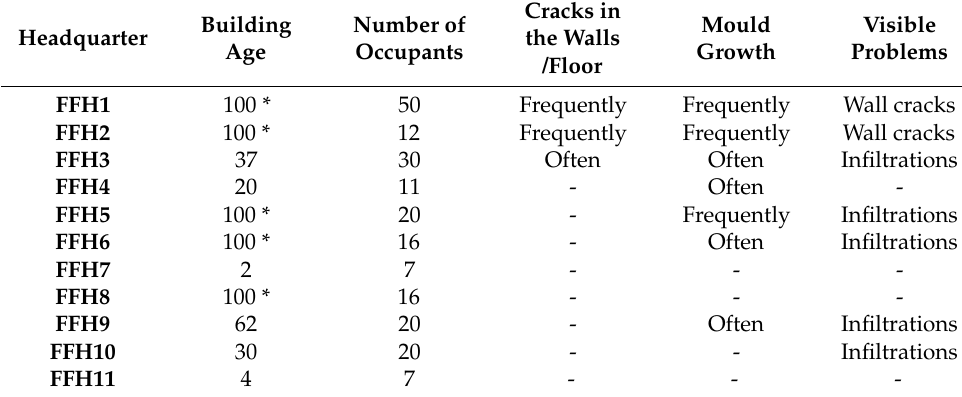
Table 1. Characterization of the 11 FFHs sampled.